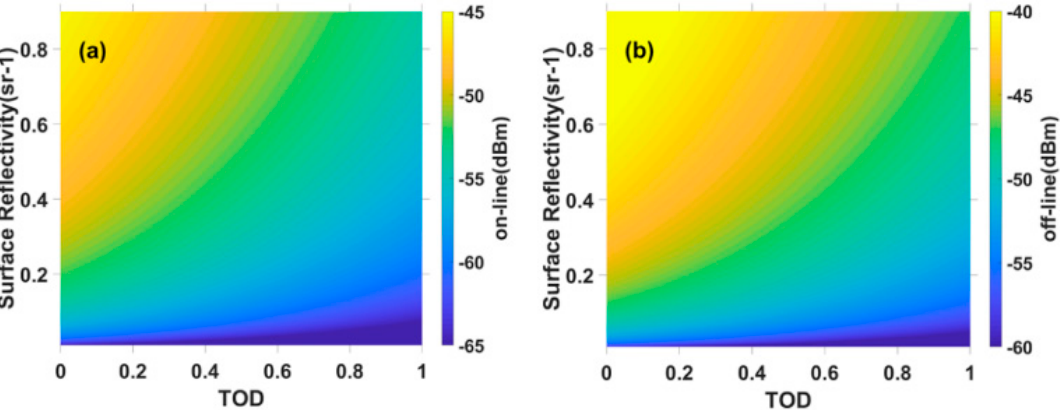
Figure 3. The power of ( a ) on ‐ line and ( b ) off ‐ line lidar echo signals varies with the total optical depth (TOD) and the nadir surface reflectivity in unit of dBm.